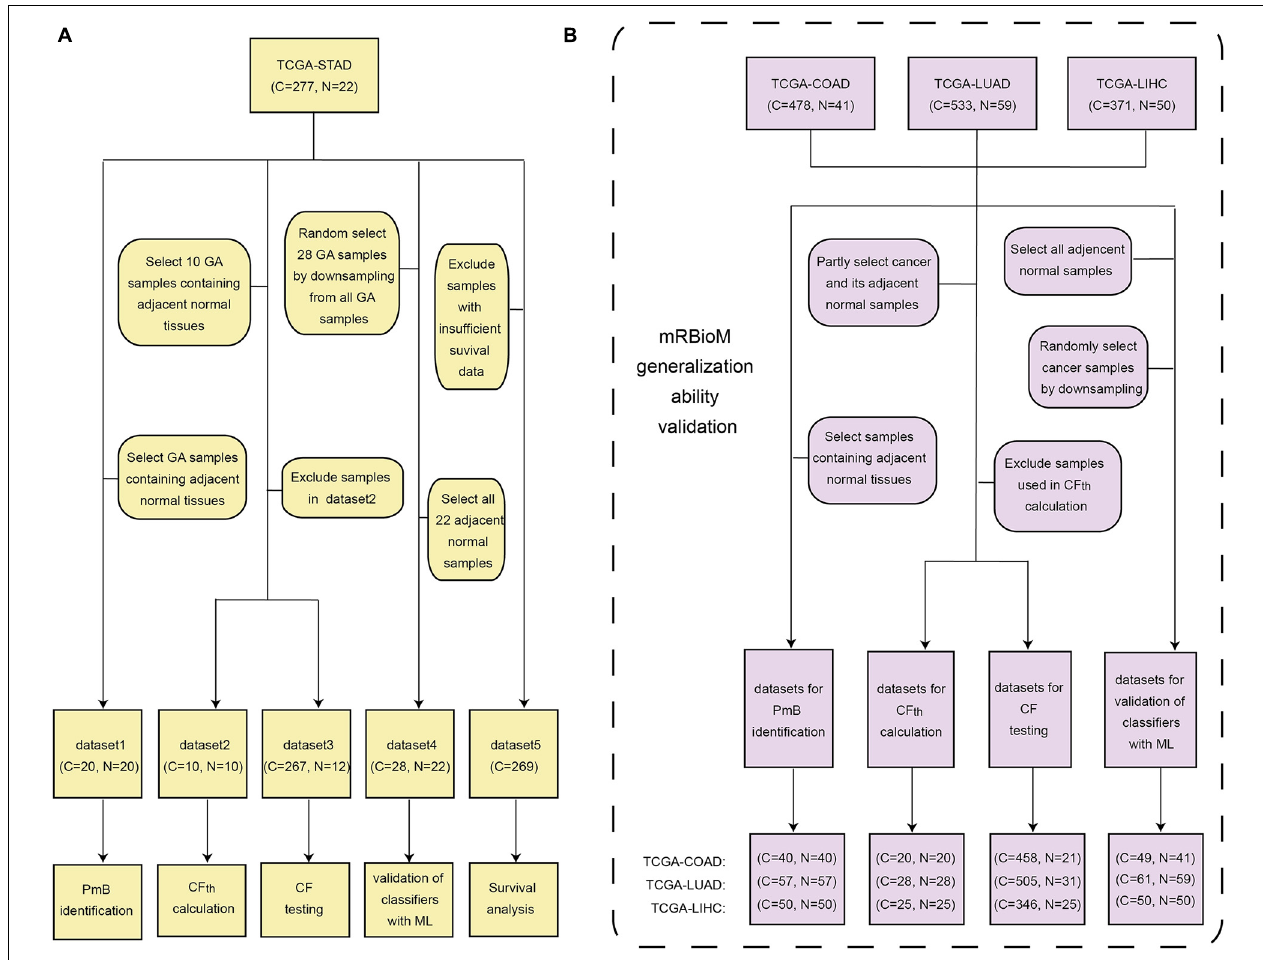
FIGURE 1 | Data organization and utilization. (A) Five subsets from the TCGA-STAD dataset. (B) TCGA-COAD, TCGA-LUAD, and TCGA-LIHC. C, cancer sample; N, adjacent normal sample; CF, cancer-related factor; CF th , threshold of CF; ML, machine